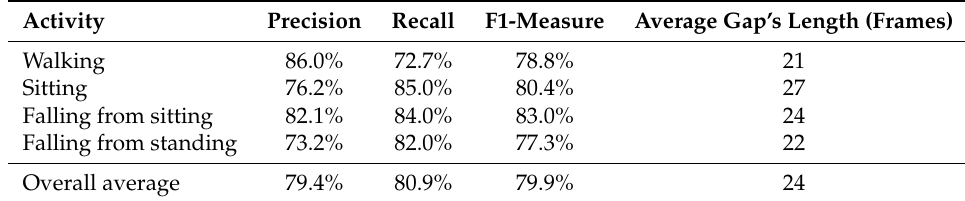
Table 6. The recognition results of the four fall-related activities from partially-observed videos when the missing subsequence of frames is at the middle of the testing video